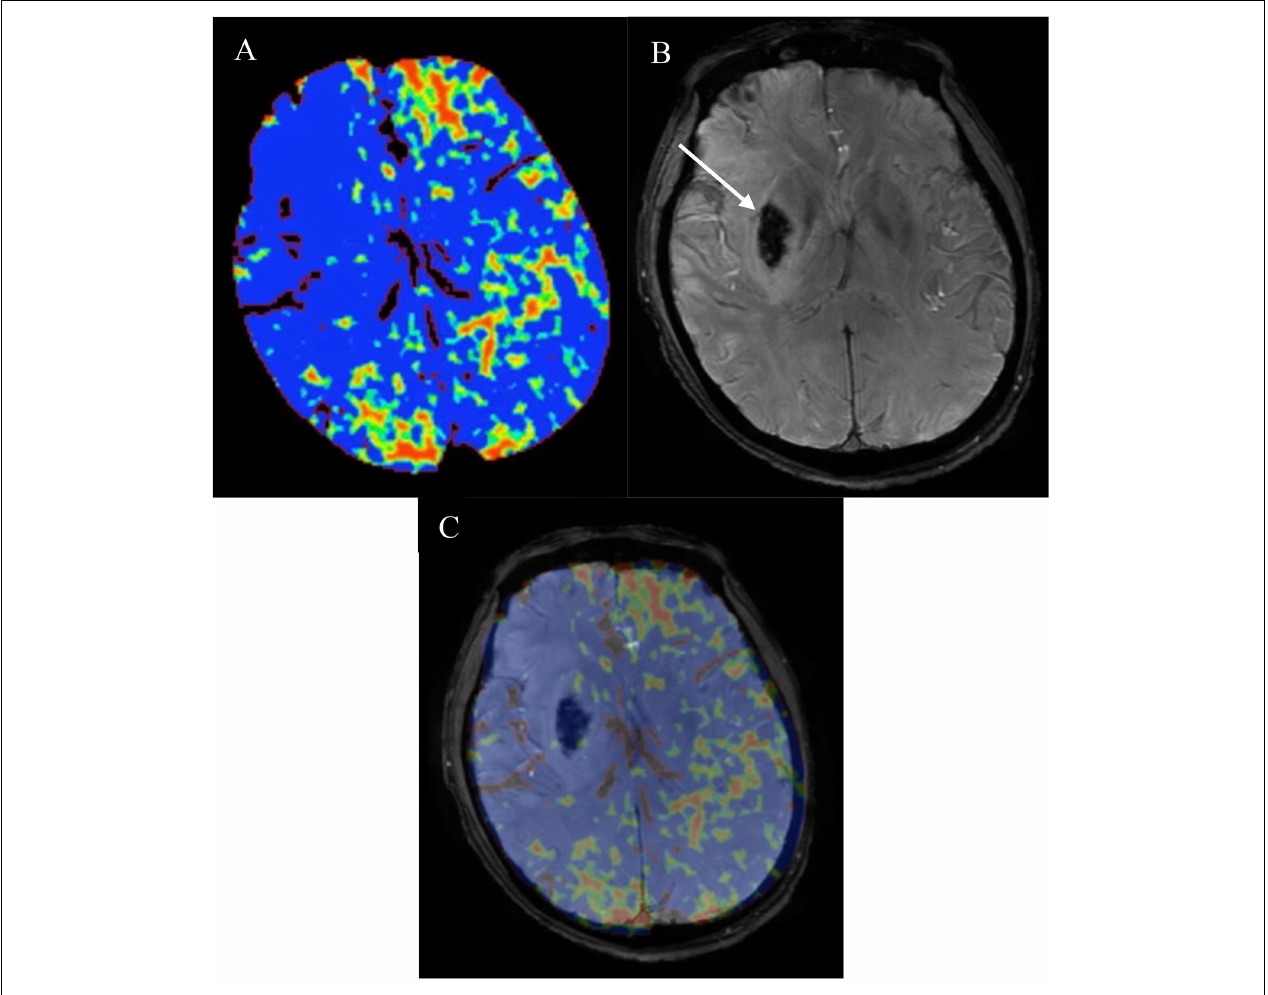
FIGURE 2 | (A) CT perfusion permeability surface (PS) map, follow-up (B) susceptibility-weighted imaging (SWI) in the same patient as in Figure 1B and (C) co-registered map. Obviously increased (A) PS on the affected side compared with the contralateral normal side. Follow-up (B) SWI showed hemorrhagic transformation (HT) (white arrow) which belonged to parenchymal hematoma (PH) 2. PS map and follow-up SWI image were co-registered automatically using OpenCV 2.4.9. Then the regions of interest (ROIs) were drawn within the HT region and the corresponding contralateral region. Relative PS were calculated by normalizing the values in the HT region with those in the contralateral mirror region. PS, permeability surface; SWI, susceptibility-weighted imaging; HT, hemorrhagic transformation; PH, parenchymal hematoma; ROIs, regions of